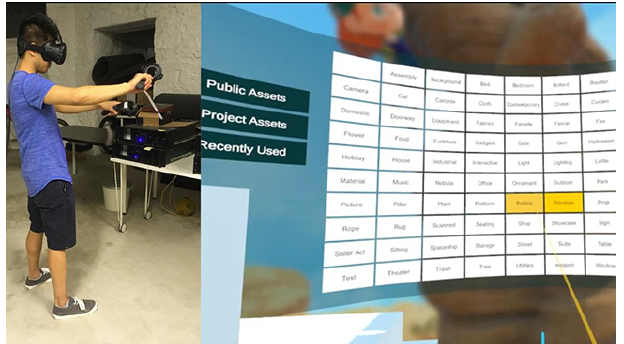
Figure 16. To place assets in the scene, the artist can pick an item from the asset library.